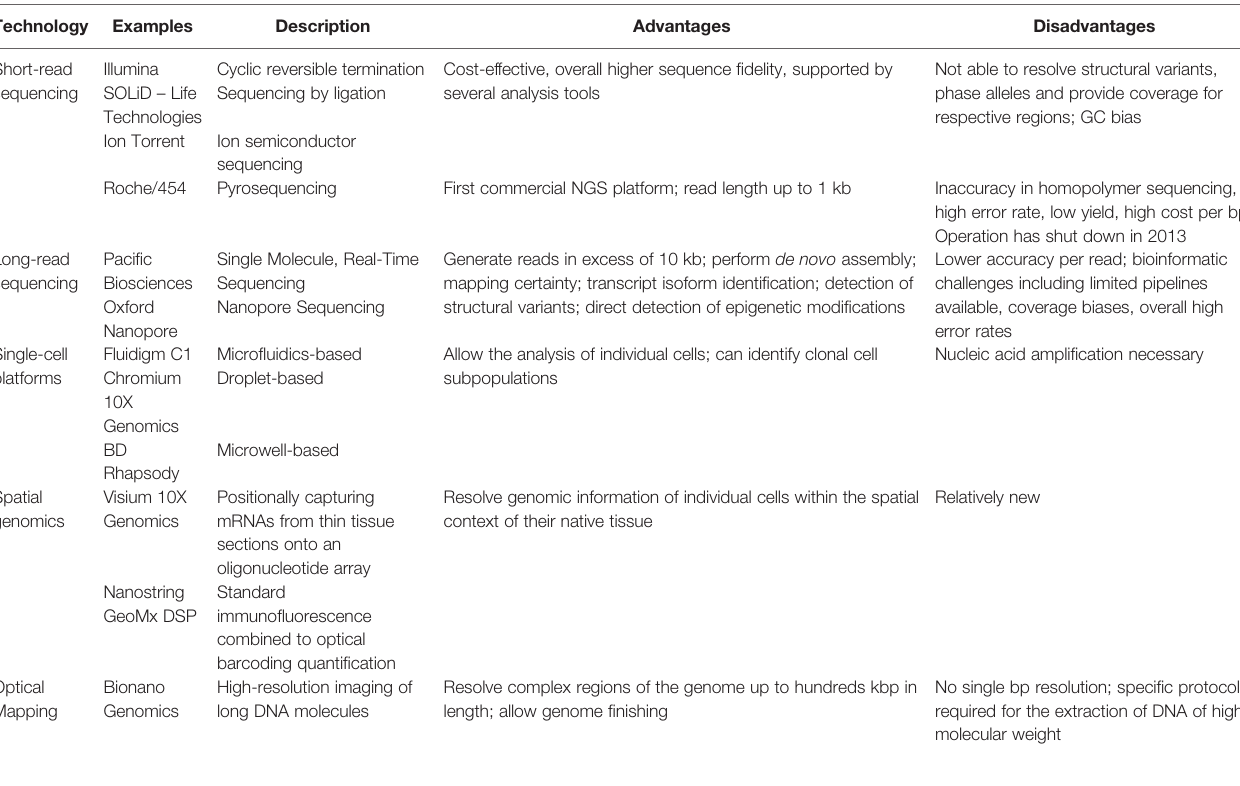
TABLE 2 | Summary of the advantages and disadvantages of the genomic technologies described in this